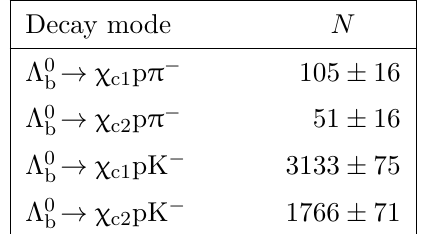
Table 1 . Signal yields, N , from the fits described in the text. The uncertainties are statistical only.